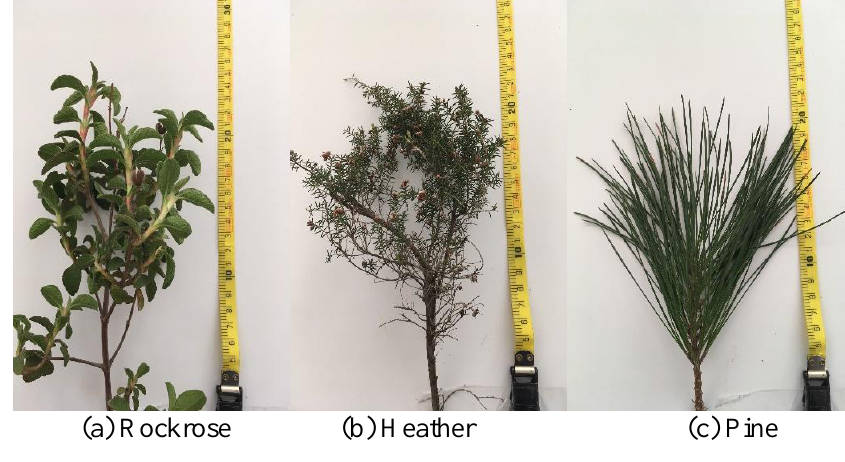
Figure 1. Picture of samples.